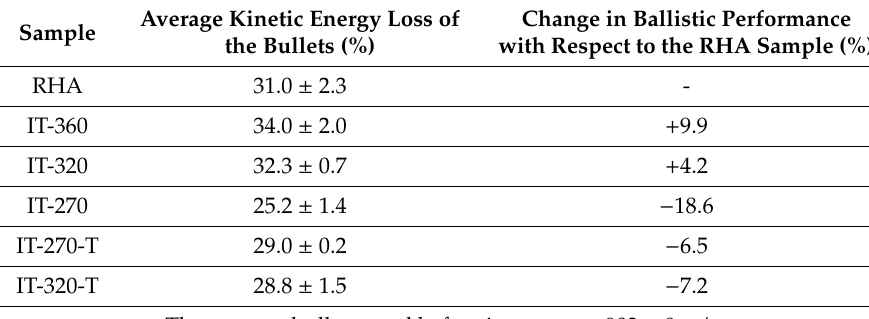
Table 4. Results of the ballistic tests.